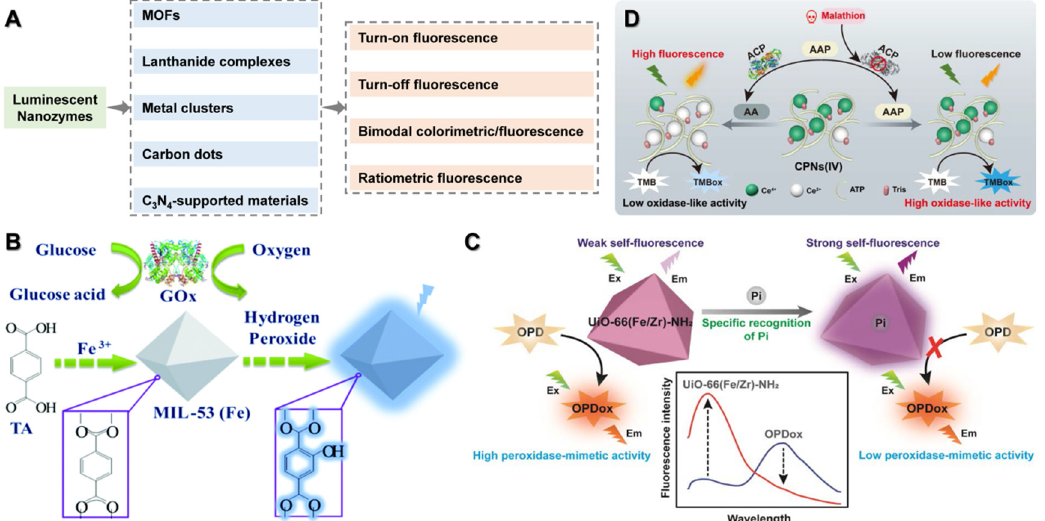
Figure 7. ( A ) Design of luminescent nanozymes for advanced fluorescence sensing. ( B ) Bifunctional MIL-53(Fe) nanozyme for label-free fluorescence detection of H 2 O 2 and glucose (reprinted with permission from Ref. [117]). ( C ) Design of UiO-66(Fe/Zr)-NH 2 enabling ratiometric fluorescence detection of Pi (reprinted with permission from Ref. [119]). ( D ) Bimodal colorimetric and fluorescence sensing of pesticides based on Ce-based coordination polymer nanoparticles with oxidase-like catalytic activity and stimulus-responsive luminescence (reprinted with permission from Ref. [128]).